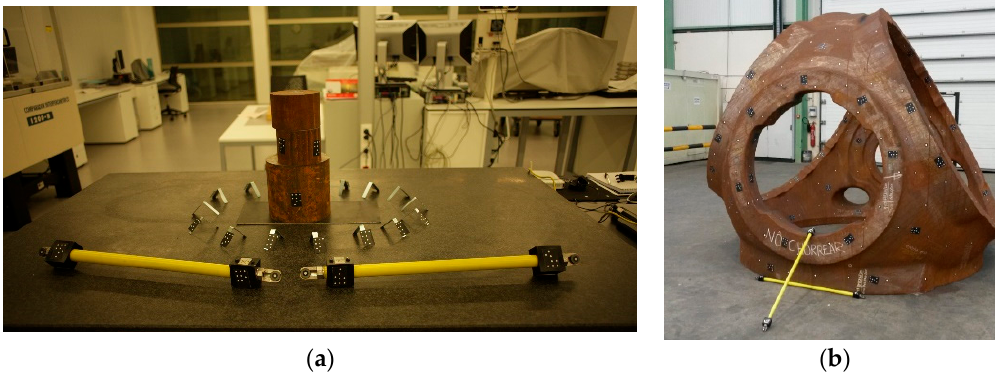
Figure 6. Coded targets and calibrated scale bar located around the textured part: ( a ) lab testing; and ( b ) shop-floor testing.